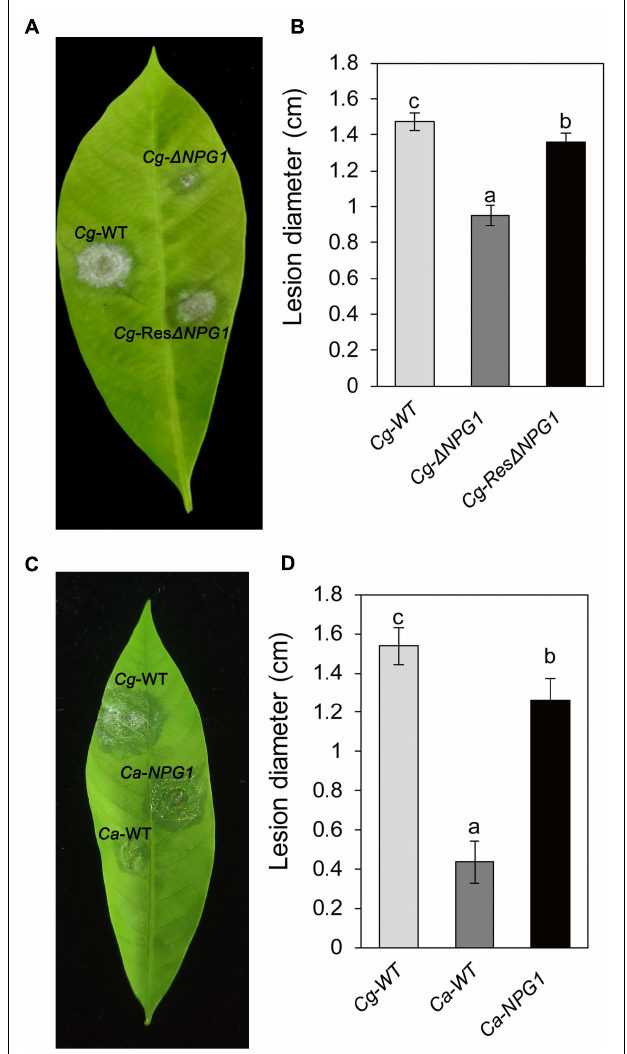
FIGURE 7 | Pathogenicity assay of CgNPG1 deletion mutant and CgNPG1 heterologous expression mutant on rubber tree leaves. (A) Disease symptoms of rubber tree leaves at 4 days post-inoculation with conidia of C. gloeosporioides Hb wild type (Cg-WT), the CgNPG1 deletion mutant (Cg- (cid:49) NPG1 ), and complementation mutant (Cg-Res (cid:49) NPG1 ) strains. (B) Lesion diameters at 4 day post-inoculation with conidia of Cg-WT, Cg- (cid:49) NPG1, and Cg-Res (cid:49) NPG1 strains. (C) Disease symptoms of rubber tree leaves at 4 days post-inoculation with conidia of C. gloeosporioides Hb wild type (Cg-WT), C. acutatum Hb wild type (Ca-WT), and the CgNPG1 heterologous expression mutant (Ca- NPG1 ) strains. (D) Lesion diameters at 4 day post-inoculation with conidia of Cg-WT, Ca-WT, and Ca- NPG1 strains. Error bars indicated standard deviation, and columns with different letters indicate significant difference ( P <